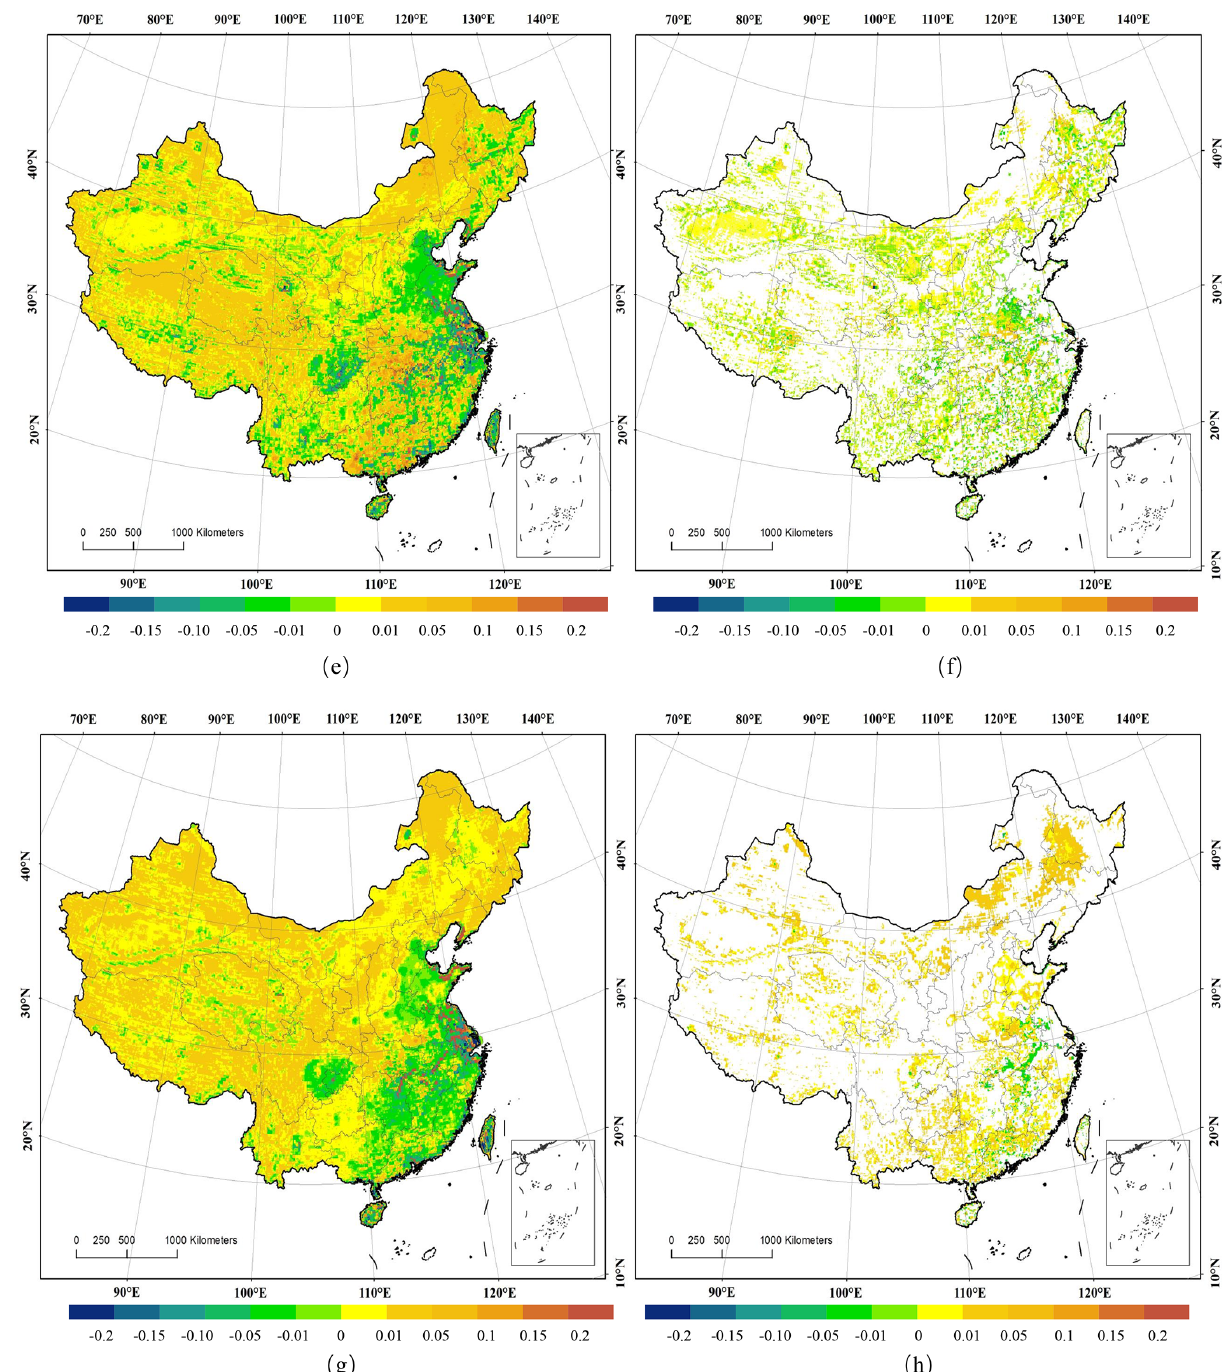
Figure 8. The interannual variability rates (slopes) and correlation coefficients ( R ) of the seasonal average SM from 2002 to 2018, for which (a) , (c) , (e) and (g) are the changing trends of all pixels in spring, summer, autumn and winter, respectively, and for which (b) , (d) , (f) and (h) are the changing trends of pixels satisfying 90% confidence in spring, summer, autumn and winter,